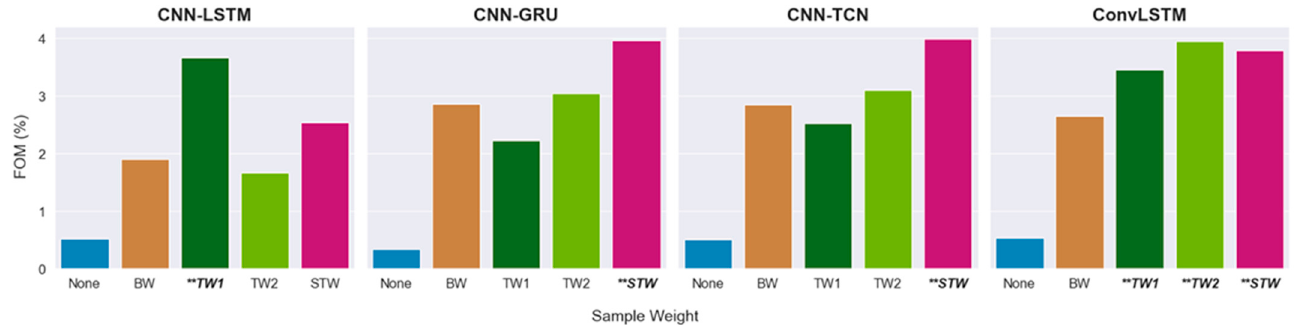
Figure 4. Figure of merit (FOM) values obtained for each model type and sample weight combina- tion for the 2016 LC forecast. The model and sample weight combinations with the top six FOM values are denoted with the prefix **.